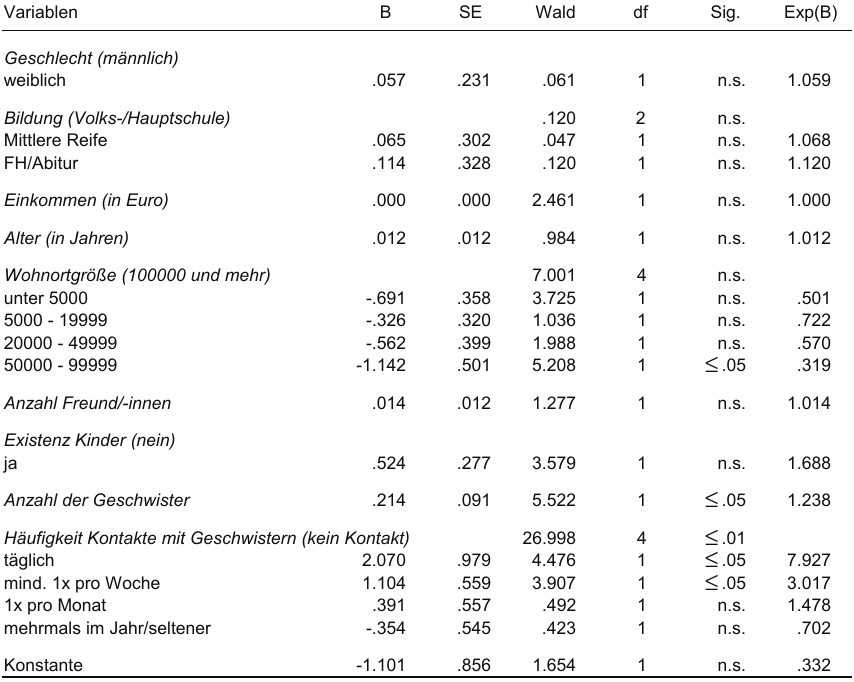
Datenbasis: ISSP 2001(gewichtet), Eigene